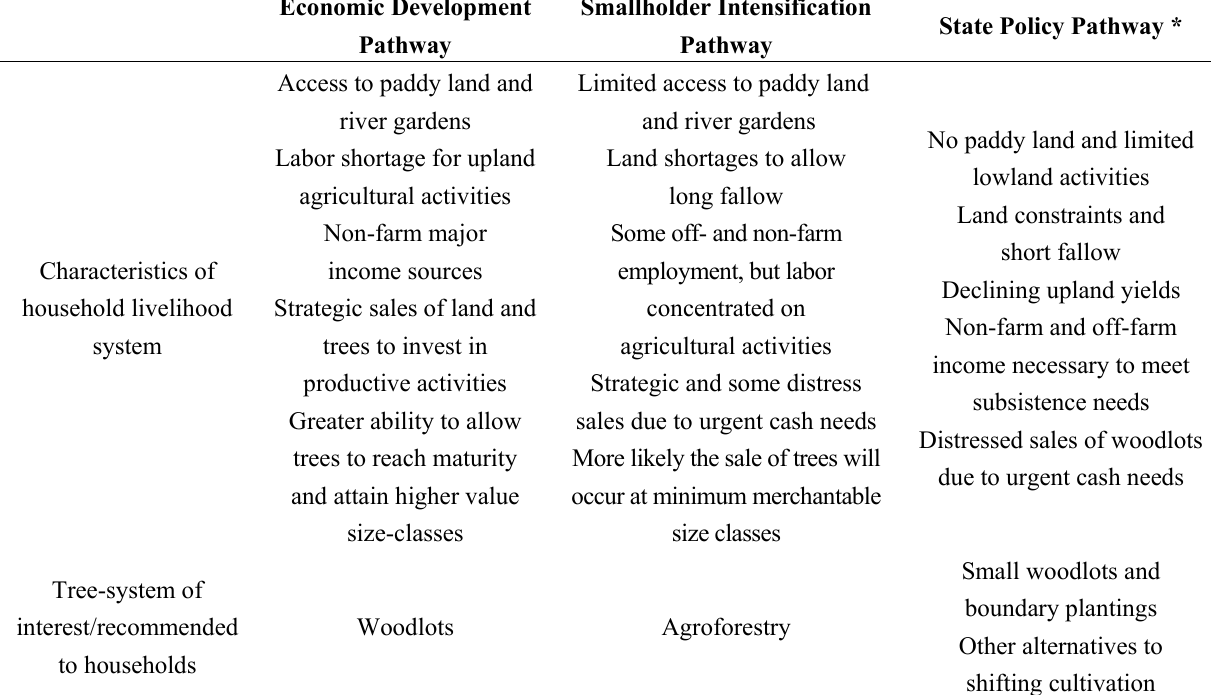
Table 3. Characteristics, opportunities, and constraints of households following different forest transition